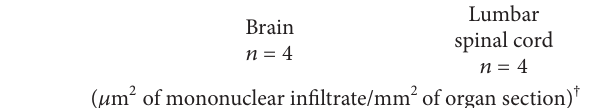
Table 1: Morphometric analysis of perivascular inflammatory infil- trate in the brain and lumbar spinal cord samples from rats immu- nized with BCG alone or associated with pVAXhsp65 before EAE